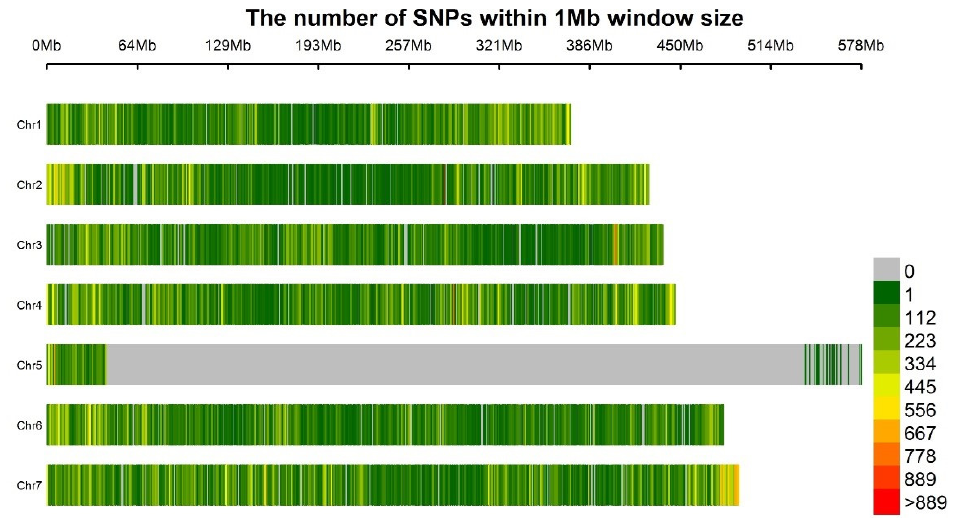
Figure 4. Distribution of polymorphic SNPs differing between Aphanomyces root rot-resistant (R) and susceptible (S) pea in three individual R-S pairs and two in silico mix bulks on the seven pea chromosomes. The colors indicate SNP density (SNPs/Mb) as per the scale on the right-hand side.